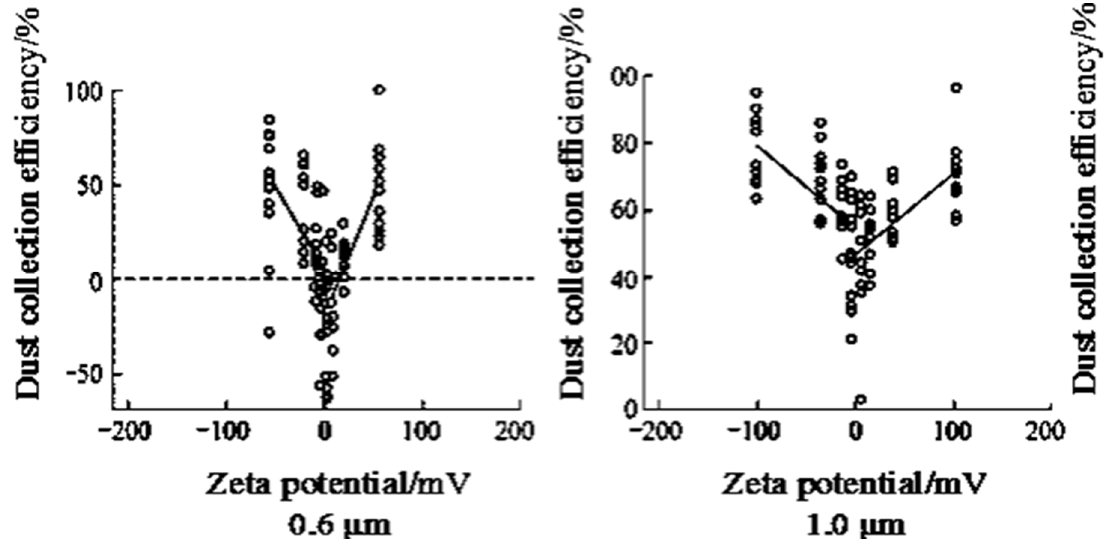
Figure 6. Relationship between coal dust aerosol and particle charge level [53].